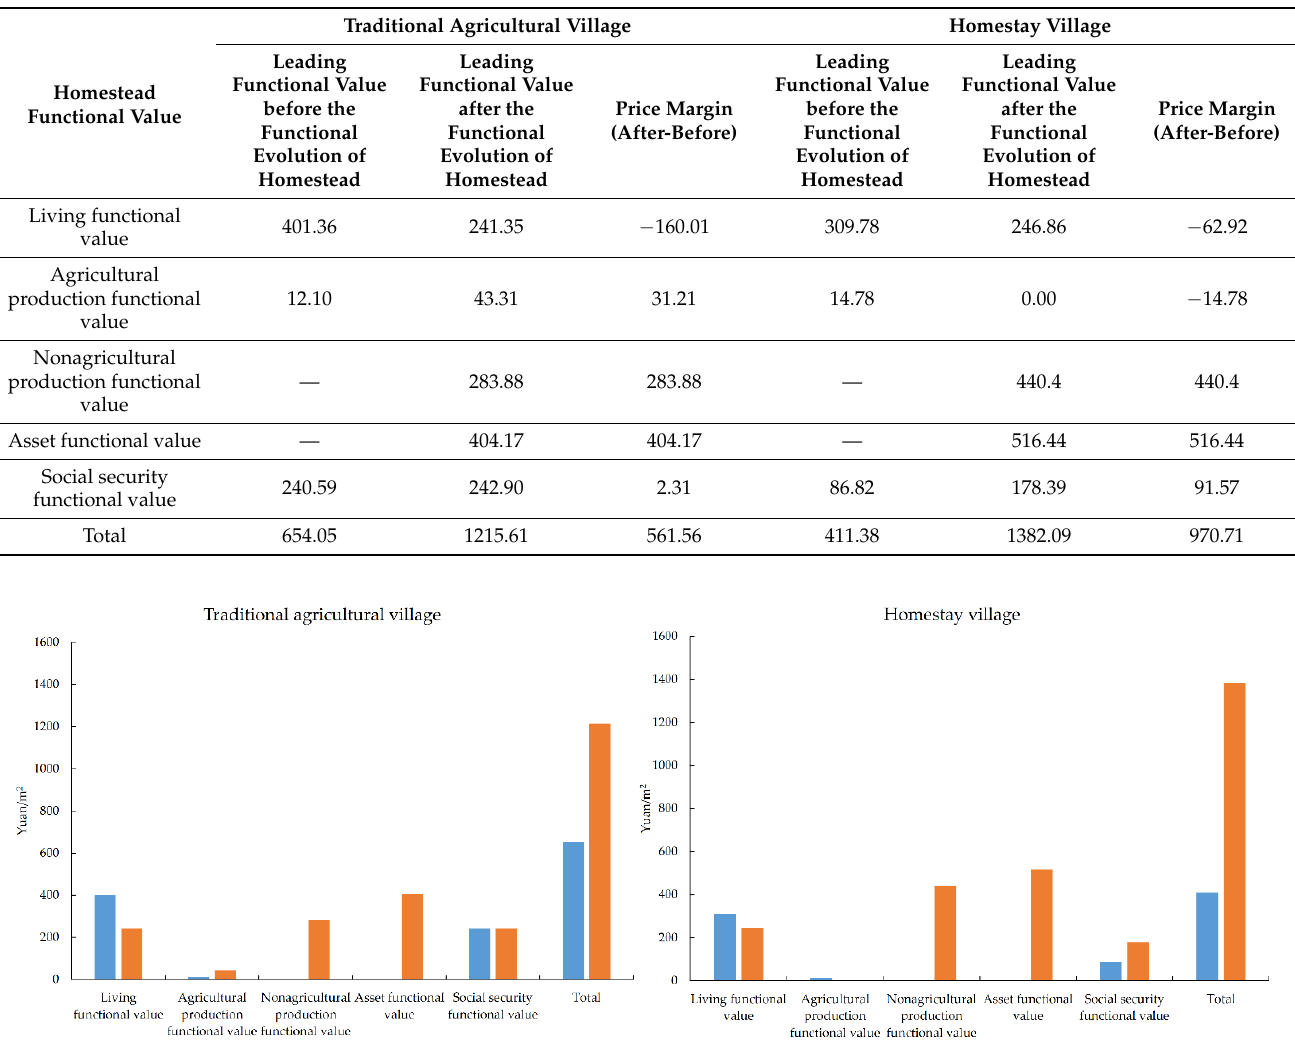
Table 4. Comparison of the functional value of homesteads between traditional agricultural villages and homestay villages (unit: yuan/m 2 ).